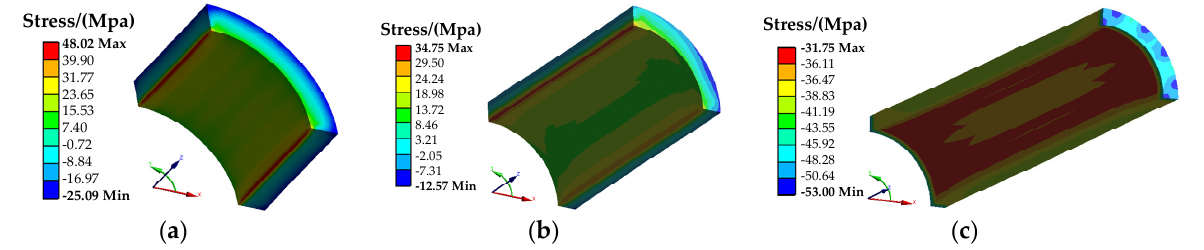
Figure 22. Permanent magnets’ tangential stress distribution under the three cases at rated speed at a hot state: ( a ) Case 1; ( b ) Case 2; ( c ) Case 3.